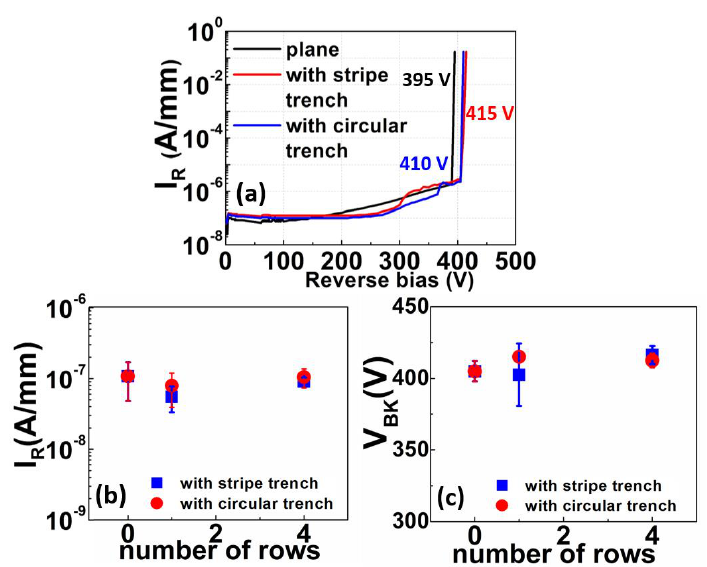
Figure 4. ( a ) the reverse-bias log scale (absolute values) two-pole characteristics for the SBDs with three different anode geometries (with four rows of circular anode trenches and L AC =10 μm); ( b ) the I R (at reverse voltage up to 200 V) for the SBDs with three different anode geometries (L AC =10 μm) vs. rows of anode trenches; ( c ) the V BK for the SBDs with three types of anode geometries (L AC =10 μm) vs. rows of anode trenches.